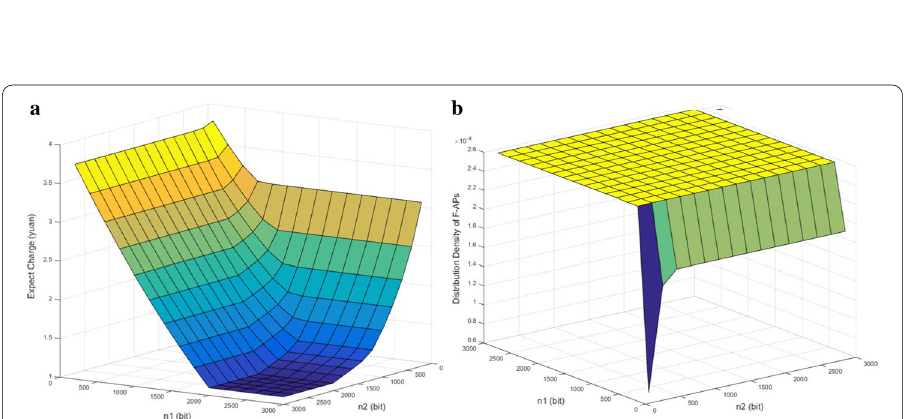
Fig. 5 Expect charge and distribution density with different value of receive capacity. a Expect charge with different value of n 1 , n 2 ; b (cid:31) 1 with different value of n 1 , n